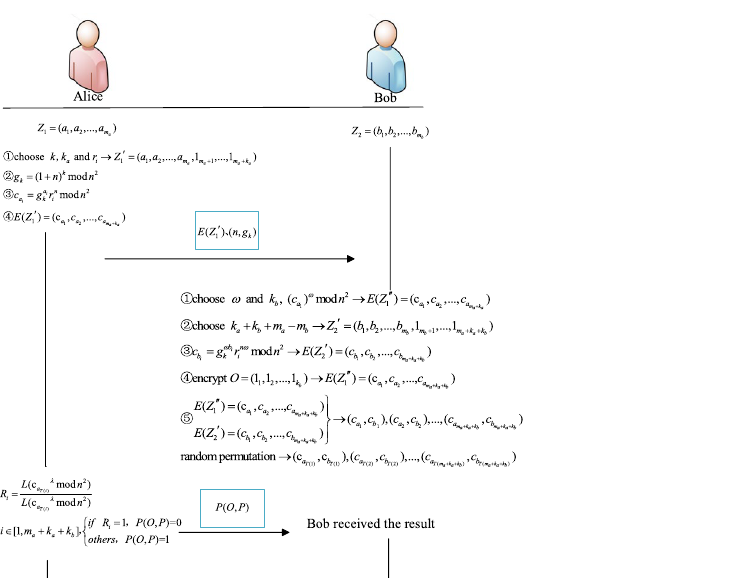
Figure 4. Protocol flow chart under the semi-honest